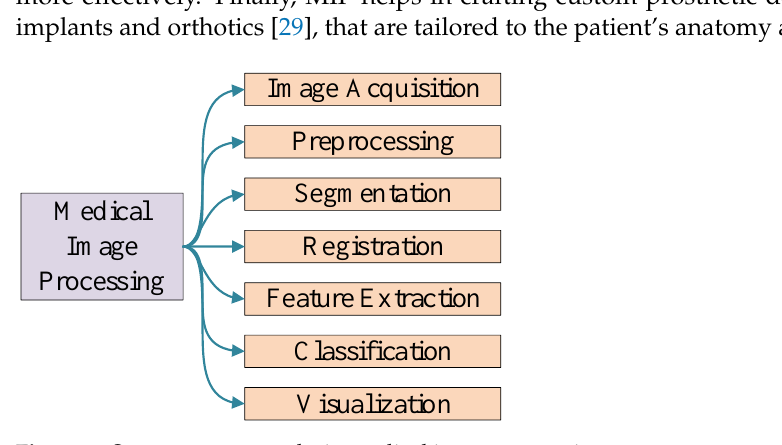
Figure 1. Seven common tasks in medical image Figure 1 . Seven common tasks in medical image processing .